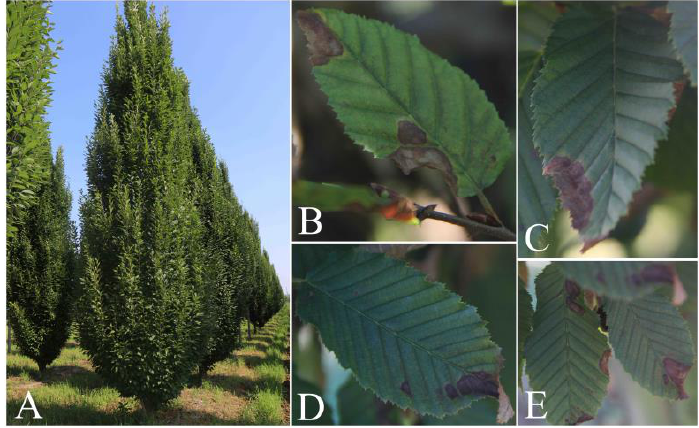
Figure 1. European hornbeam leaves with disease symptoms under natural conditions. ( A ) Diseased tree in the field. ( B – E ) Diseased leaves of European hornbeam.